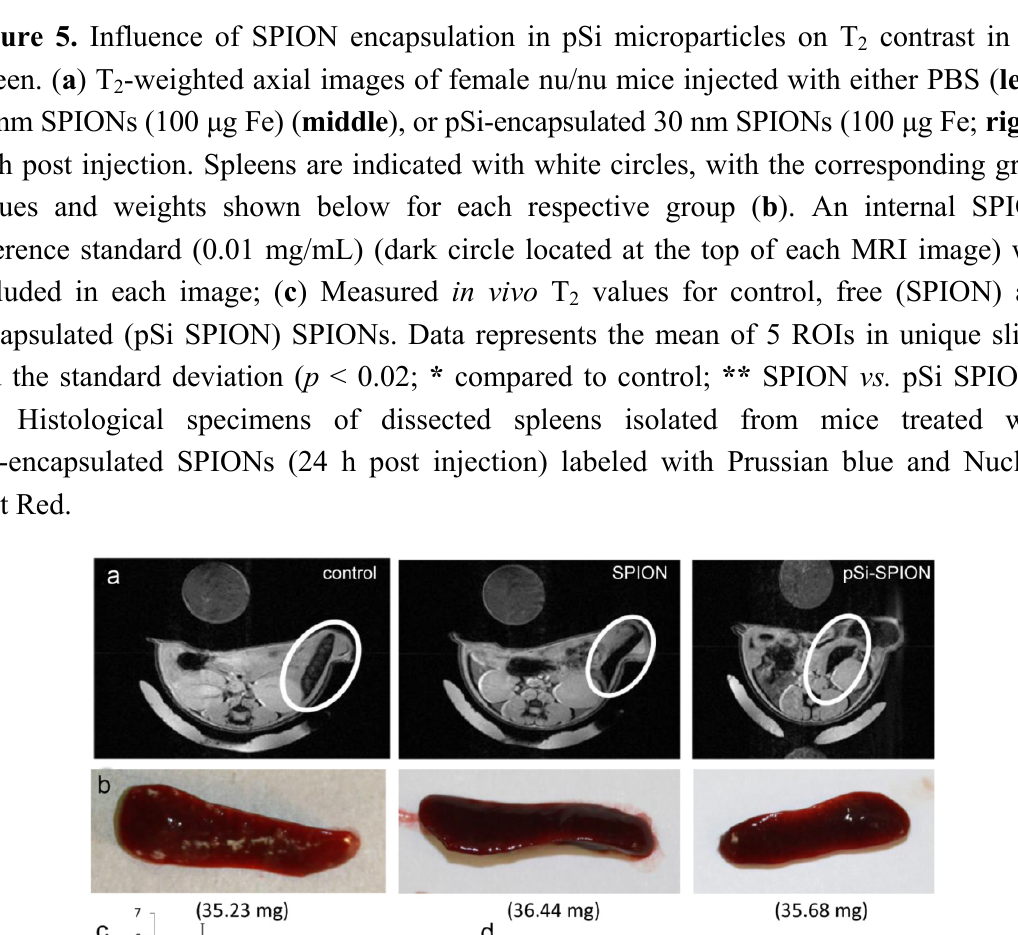
Figure 5. Influence of SPION encapsulation in pSi microparticles on T